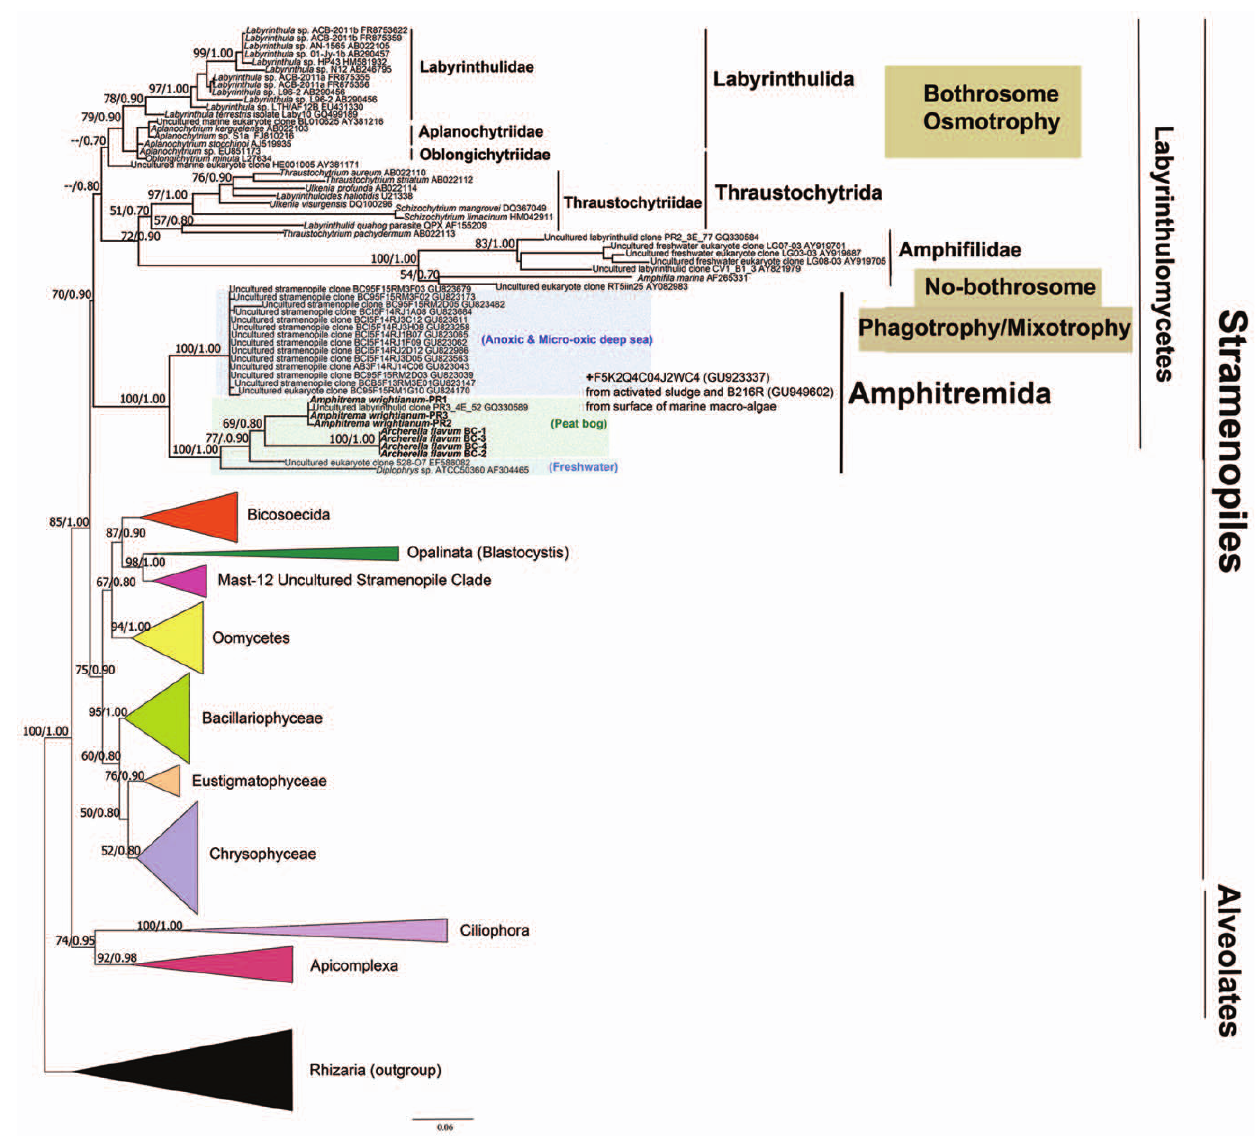
Figure 2. Molecular phylogenetic tree inferred from both maximum likelihood and Bayesian analysis based on small subunit (SSU) rRNA gene sequences and illustrating that the genera Archerella and Amphitrema (Amphitremida) belong to Labyrinthulomycetes (Stramenopiles). Numbers at nodes indicate the bootstrap values/posterior probabilities. Only values above 50/0.50 are shown. The tree was rooted with the group of Rhizaria. The scale bar indicates 0.06% sequence divergence.